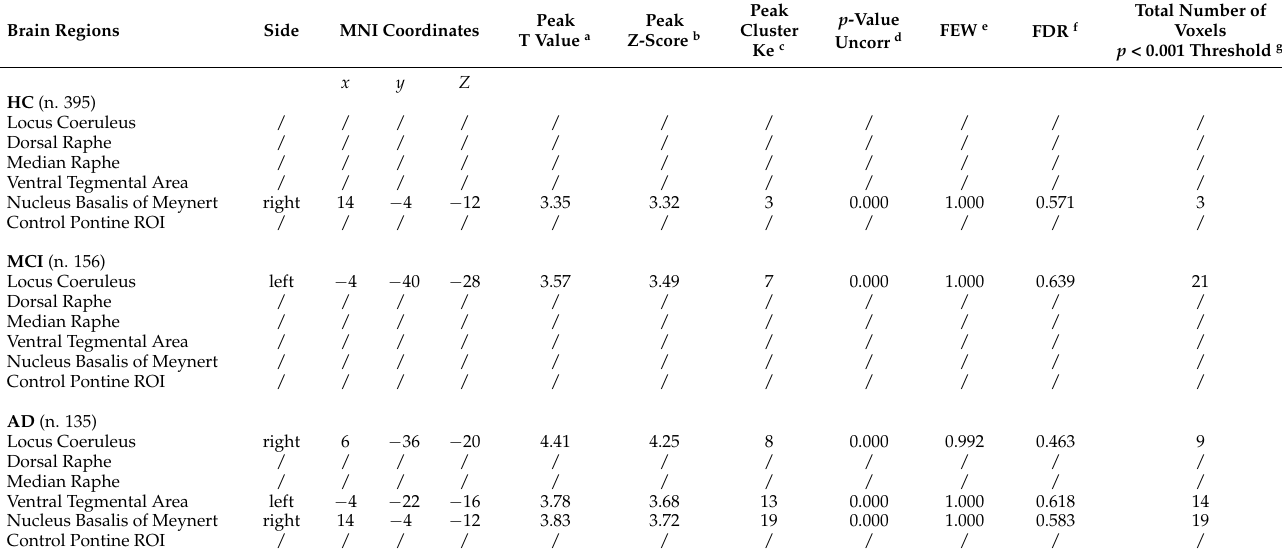
Table 2. VBM multivariate linear regression analyses for the six ROIs across the three groups (HC n = 395; MCI n = 156; AD n = 135). The results were adjusted for total intracranial volume (TIV), and age and education were entered as continuous variables. TMT-A time in seconds was treated as a continuous dependent variable and the structural scans as the independent variable. For a statistical threshold of p < 0.001, the table reports the number of significant voxels negatively related to TMT-A time in seconds.